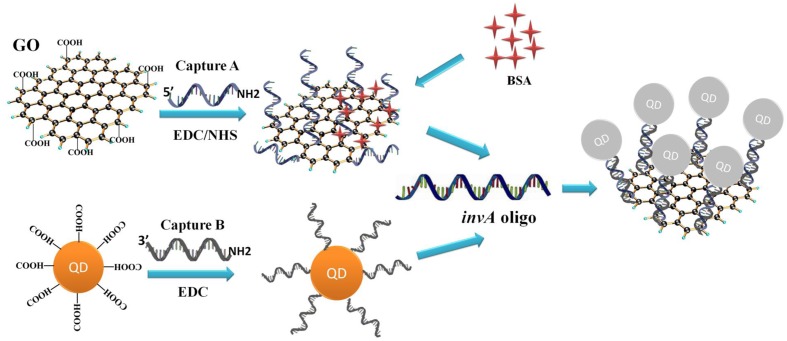
Principle of GO-QDs FRET biosensor. In the system, carboxyl QDs (donor) and GO (quencher) were first conjugated with the capture probes B and A, respectively, with the aid of EDC/NHS. Upon the addition of the complementary invA oligo of Salmonella, the QD and GO conjugates could be brought into close proximity to make the FRET pair work, the energy emitted from excited QDs would be quenched by GO.